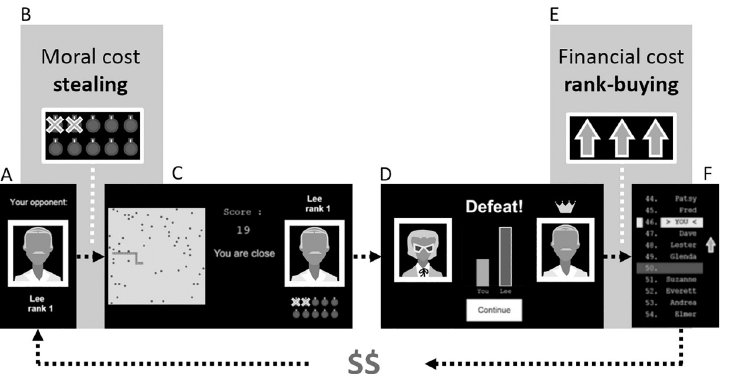
Fig 1. Task description. Each of the 24 trials has the following steps: (A), new opponent is displayed with name and league rank (participants are told that these opponents are all previous players whose performance has been prerecorded); (B), 1st outcome measure: willingness to steal points from the opponent’s future score in order to increase one’s chance of defeating him/her; (C), playing the snake arcade game for 20 seconds, with the goal of gathering as many points (apples) as possible, while one’s score (the number of apples caught) is displayed, as well as a message at 10 seconds informing the participant whether he/she is ahead, behind, or the outcome is close; (D), learning the contest’s outcome, which defines whether the participant will move 5 ranks up or down in the global ranking. These outcomes are rigged towards a 2:1 defeat to victory ratio occurring in a pseudorandom order; (E), 2nd outcome measure: willingness to buy extra rank; (F), learning current rank in the competition. ($ $), each trial starts with a renewed virtual endowment that the participant can choose to spend on extra ranks. Participants are told that their real money payoff will be computed based on their savings from three random trials. Note. The computer version is in